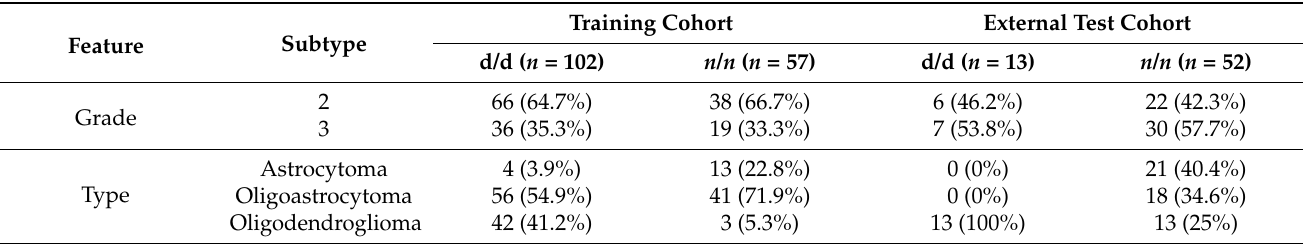
Table 5. Patients’